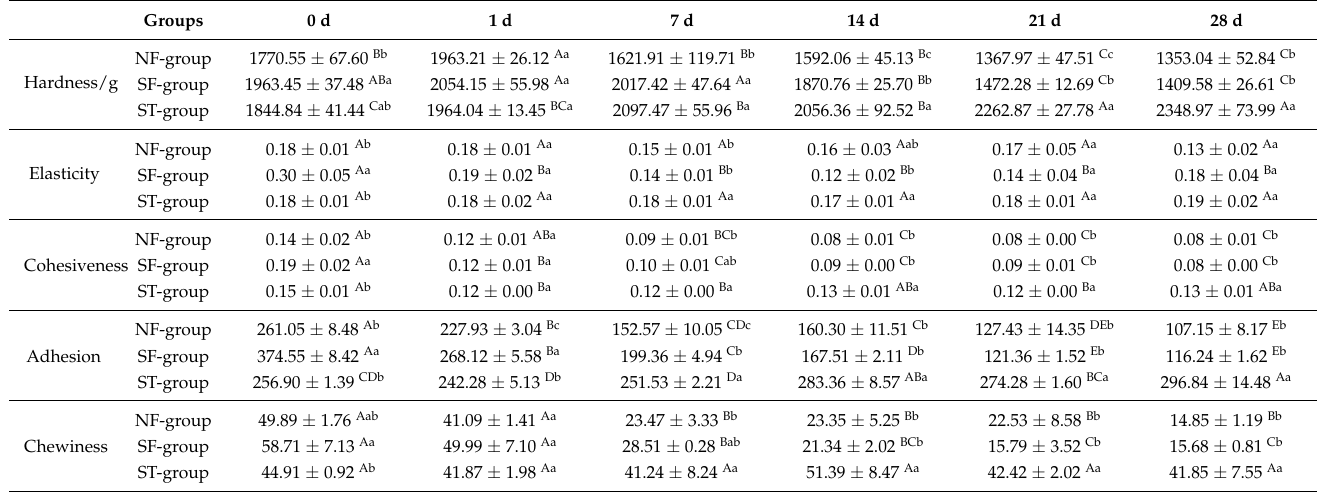
Table 1. Differences in the texture of lamb liver paste during storage.